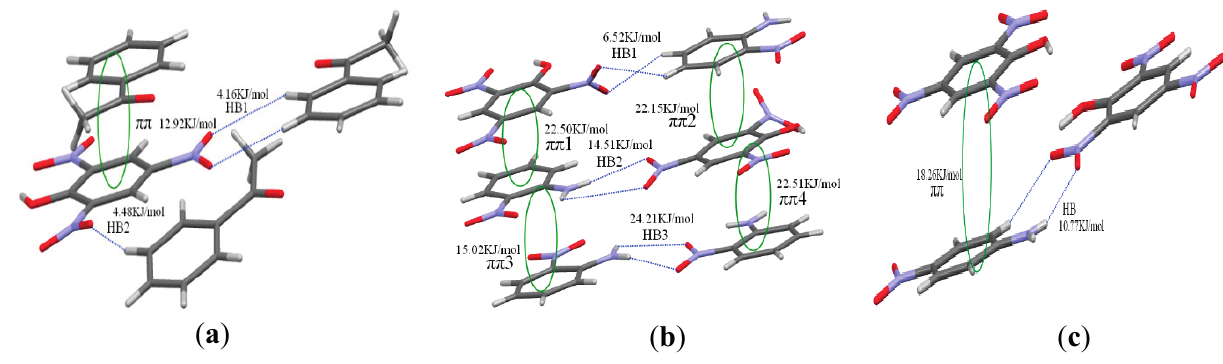
Figure 4. The energetic contributions of intermolecular π - π interactions and hydrogen bonding interactions in: ( a ) cocrystal 1; ( b ) cocrystal 2; ( c ) cocrystal